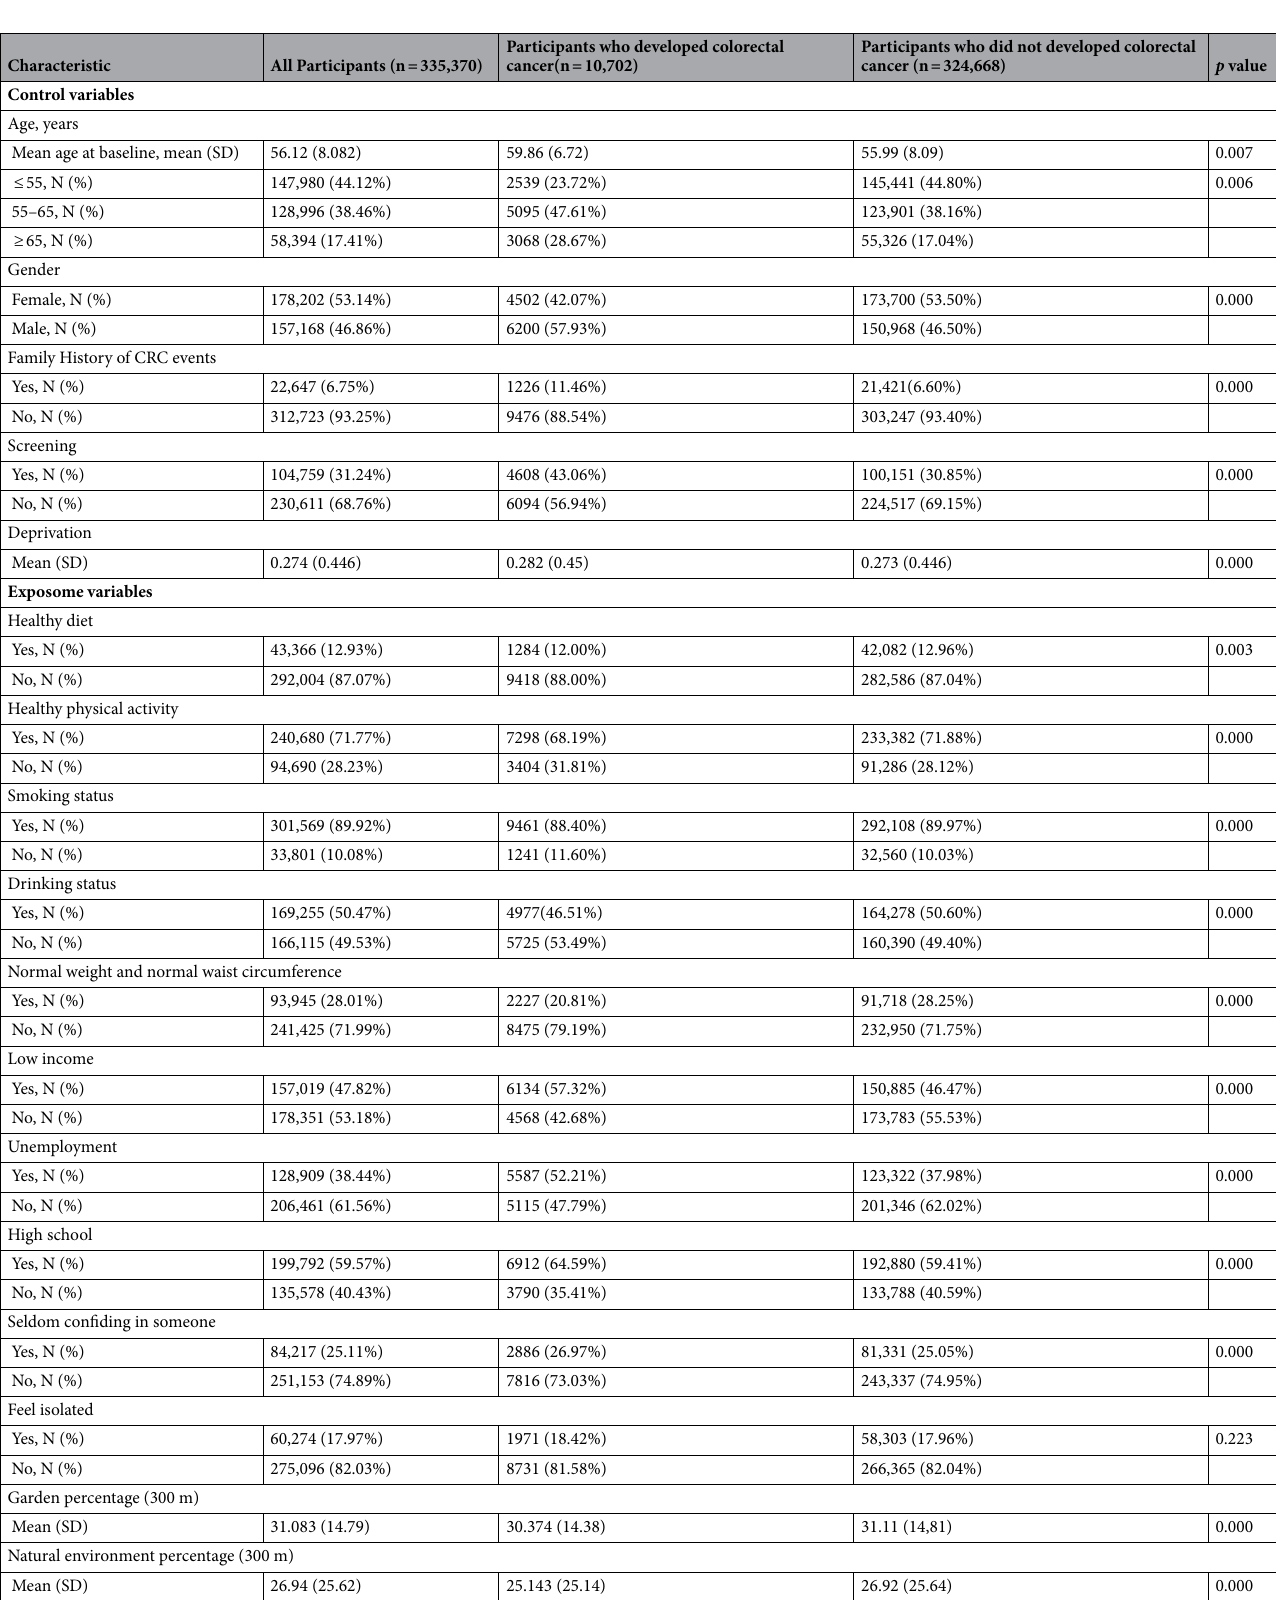
Table 2. A statistical description of respondents’ characteristics (n =